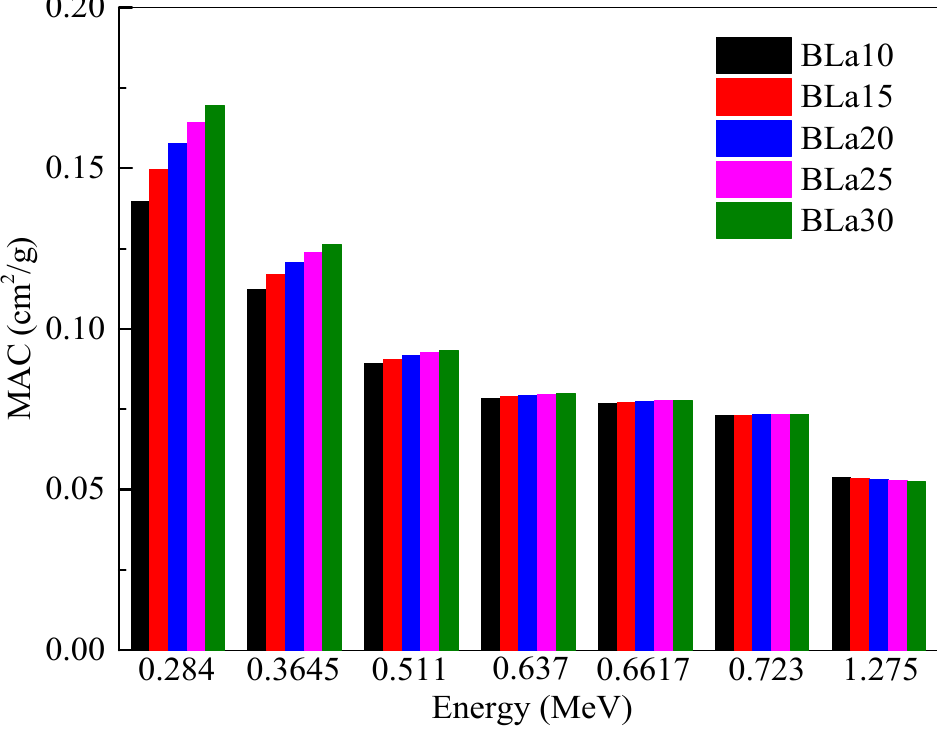
Figure 3. Mass attenuation coefficient ( MAC ) of the chosen samples at 0.284, 0.3645, 0.511, 0.637, 0.6617, 0.723 and 1.275 MeV.